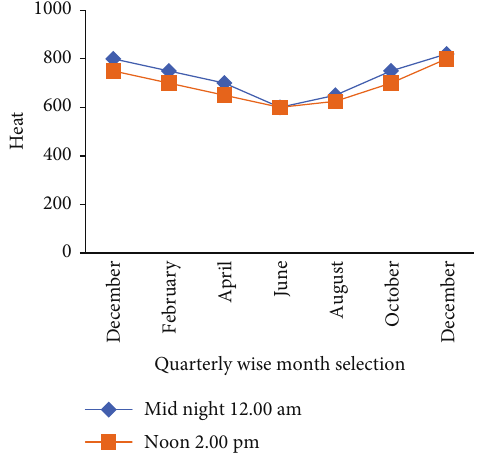
Figure 10: Solar irradiation absorption by ETC.